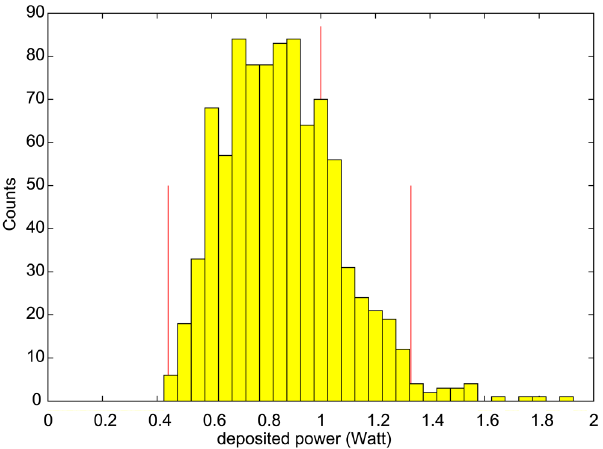
FIG. 25. (Color) Empirical bootstrap distribution for the return level with a probability of 0 : 99 . The two small red marks indicate the (cid:5) 2 (cid:1) interval, the big red mark indicates the return level obtained with a direct estimate from the recorded losses.